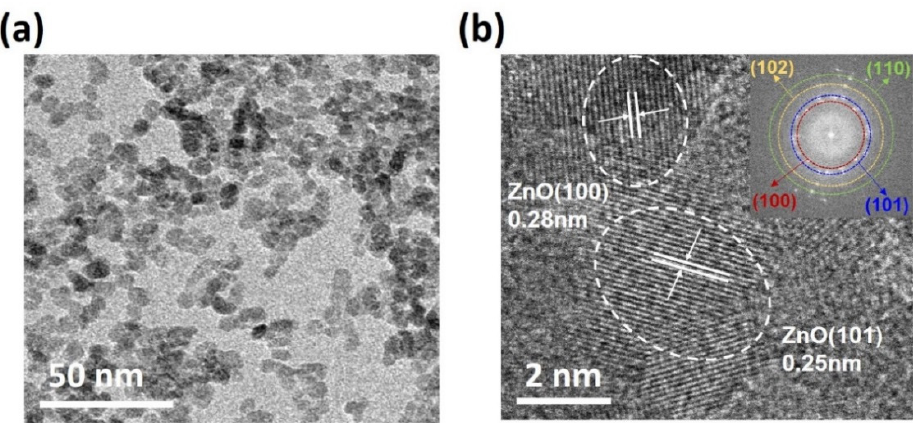
Figure 4. ( a ) TEM and ( b ) HRTEM image of as-synthesized ZnO NPs (inset: FFT pattern).